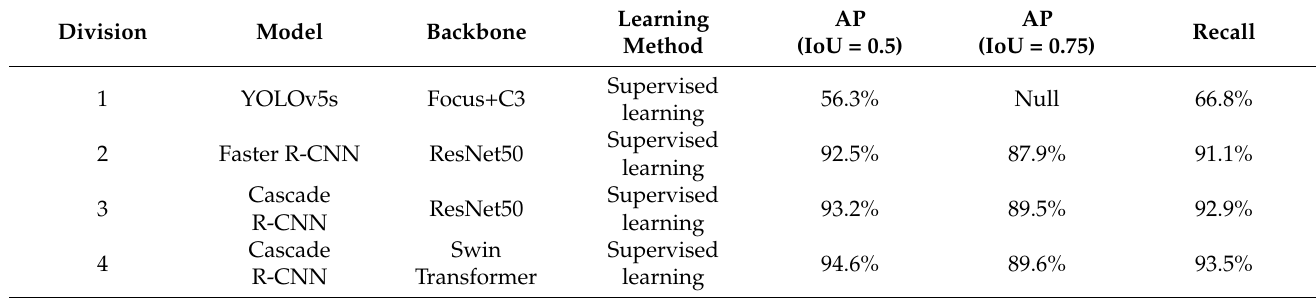
Table 4. Comparison of performances of 4 models for detecting pine